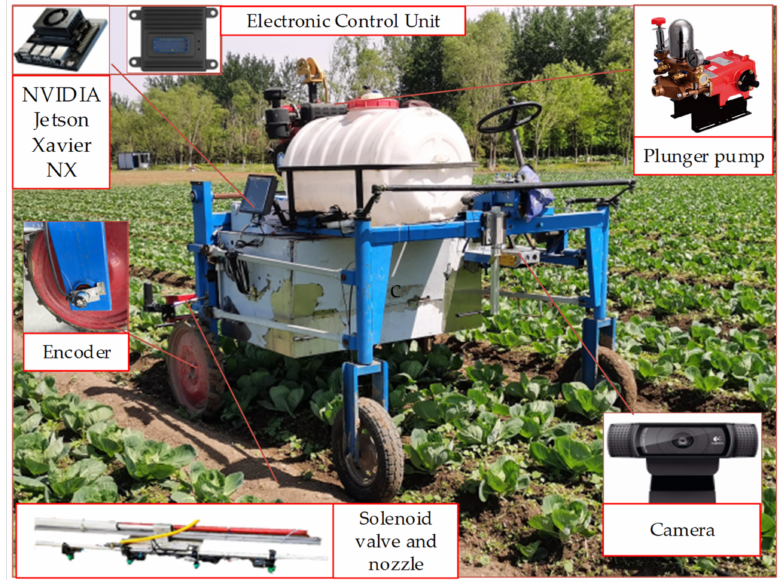
Figure 7. Photographs of the target-oriented spray platform and its